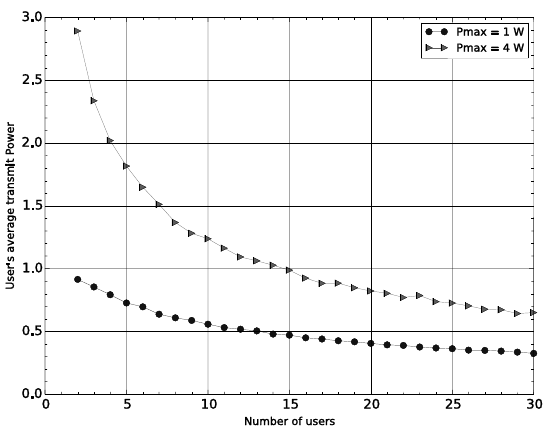
Fig. 1. User’s average transmit power under different allowed power levels.